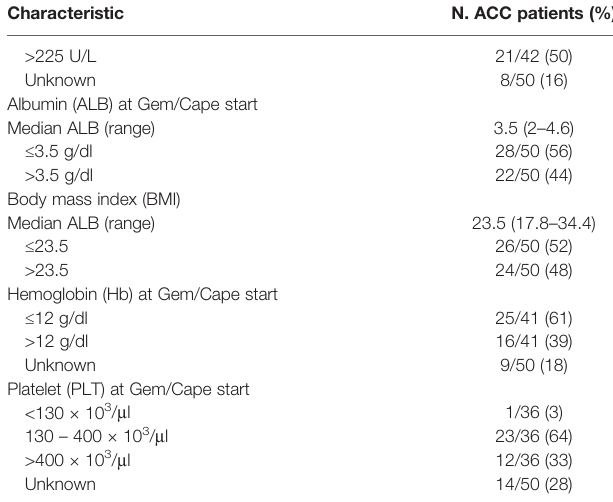
Two sets of variables were evaluated: traditional prognostic clinico-pathological variables (including ENSAT stage, Ki67, resection status, hormonal hypersecretion) at initial diagnosis and patients clinical characteristics before the start of Gem/Cape chemotherapy (including ECOG PS, comorbidities, pattern of metastases distribution) and laboratory abnormalities. All sets of variables were tested for their predictive and prognostic value in terms of PFS and DSS. Included variables are summarized in Tables 3 and 4 . Among the variables at initial diagnosis only no- frontline surgery of the primary tumor resulted predictive of shorter PFS during Gem/Cape therapy at univariate analysis (p.014). Clinical variables evaluated before the start of Gem/Cape associated with a higher risk of progression at univariate analysis included: ECOG PS ≥ 1 (p <.0005), lung metastases (p.040),